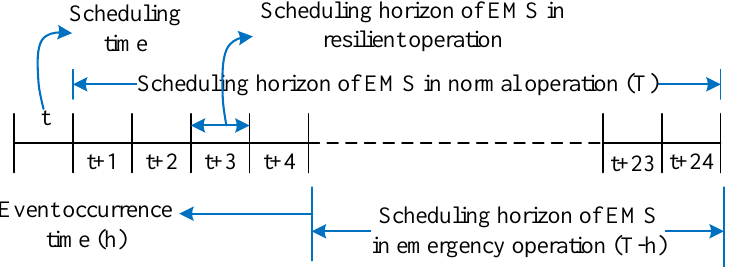
Figure 5. Scheduling horizons of different operation modes of the proposed hybrid microgrid.